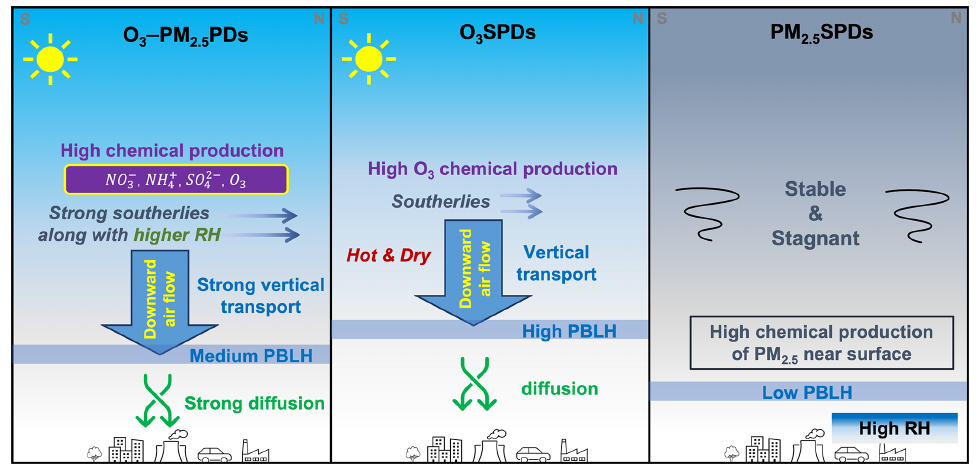
Figure 13. A schematic diagram of chemical and physical and characteristics on O 3 SPDs, PM 2 . 5 SPDs, and O 3 –PM 2 . 5 PDs in BTH region.